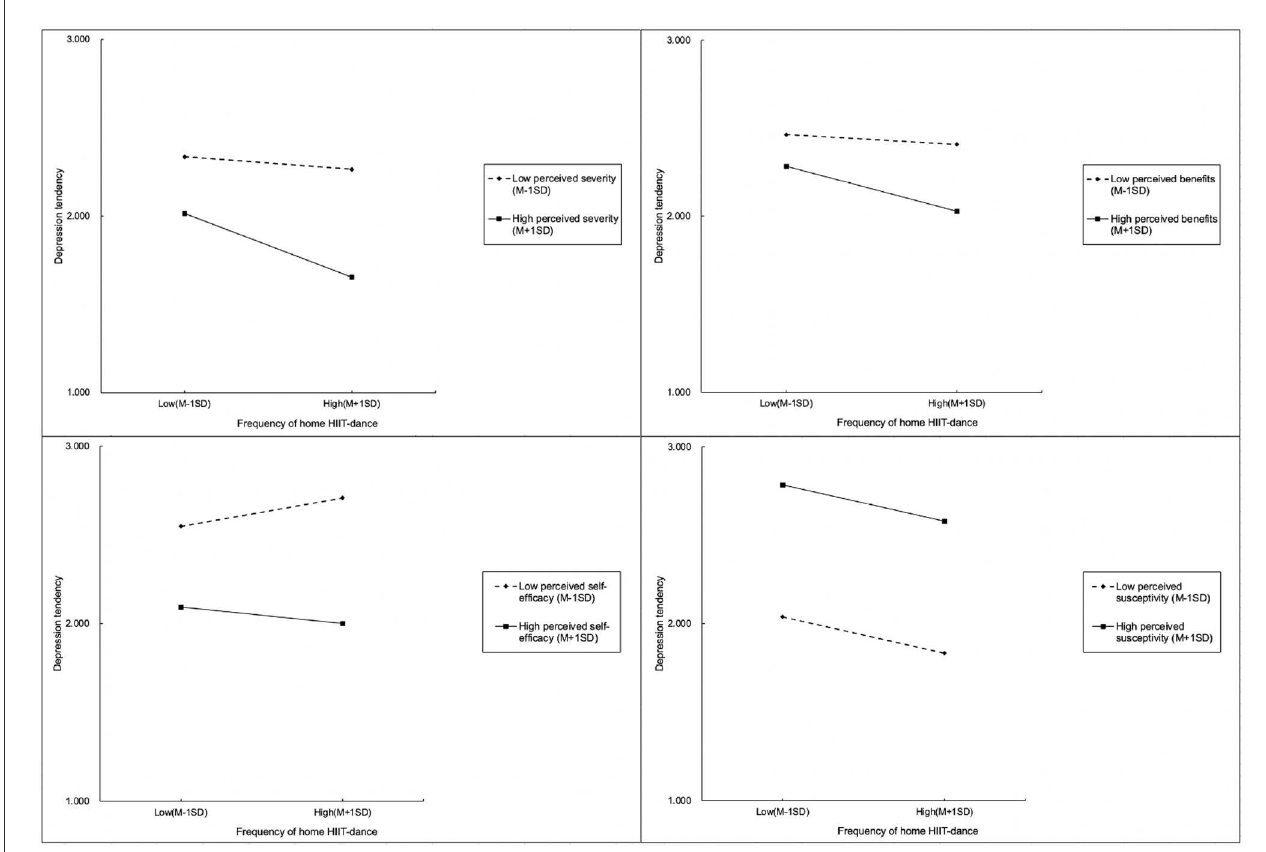
FIGURE2 Simple slope test results of the mediated effects of personal perceived